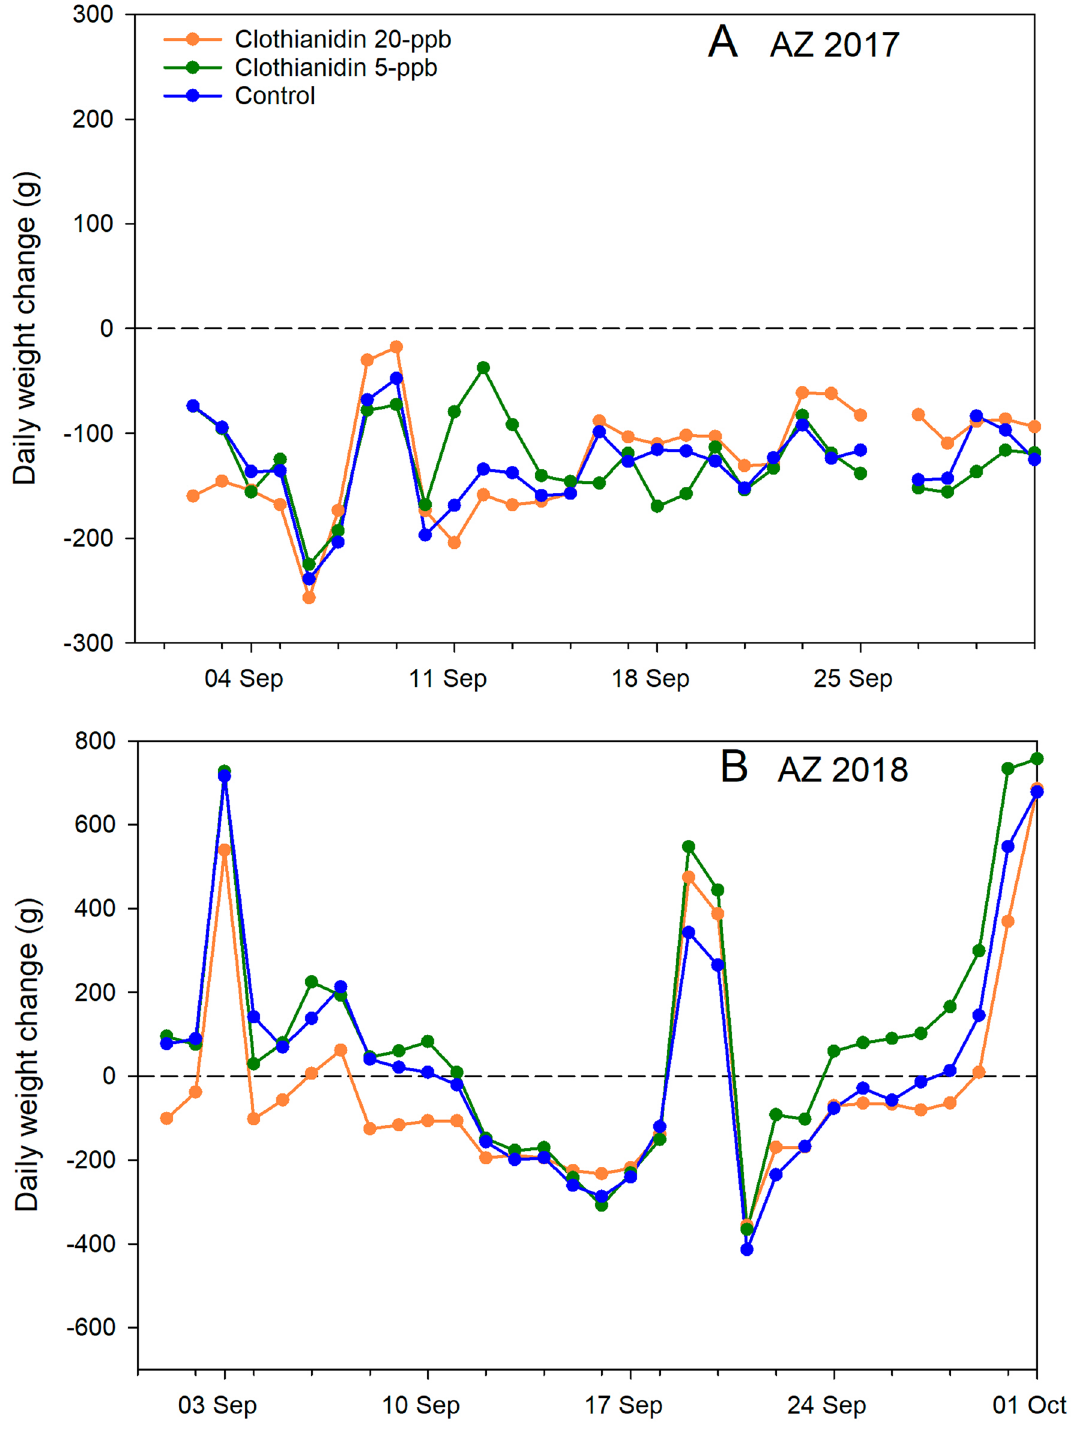
Figure 5. Average colony daily weight change (g) for each of 3 treatment groups: Clothianidin 20-ppb (orange), clothianidin 5-ppb (green), control (blue) for the month of September for 2 experiments. ( A ) AZ 2017; ( B ) AZ